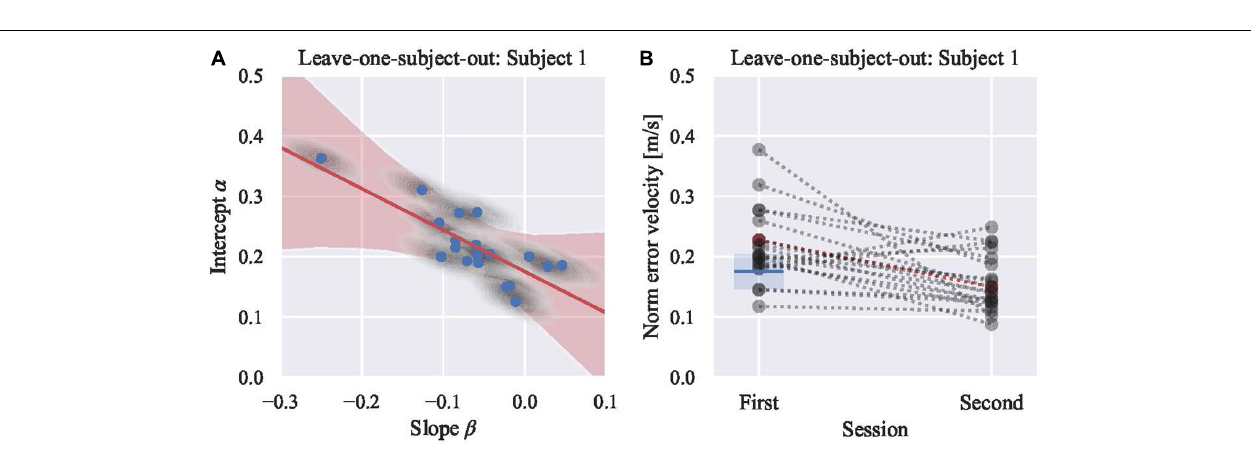
FIGURE 5 | (A) Posterior predictive plot of model 4 using 19 participants’ norm of error velocity (leaving subject 1). Each gray shaded area represents multiple samples from the posterior [the intercepts ( α ) and the slopes ( β )] of each subject, and each blue circle shows the average of each area. Red shaded area represents regression lines for all samples, and red line shows their average. The boundary ( γ , the intercept of the red line) is 0.175 m/s with the credible interval (94%) from 0.147 to 0.204 m/s. (B) Visualization of classifying results. Subject 1, showing in red marker, is tested. Rest of 19 participants are showing in gray markers. Blue line shows the boundary derived from model 4 in (A) . Blue shaded area shows the 94% credible interval. Mean norm of error velocity of Subject 1 in the first session was above the boundary. Thus, subject 1 is classified into a group that is expected to improve the performance in the second session. Actual mean norm of error velocity in the second session is less than that of the first